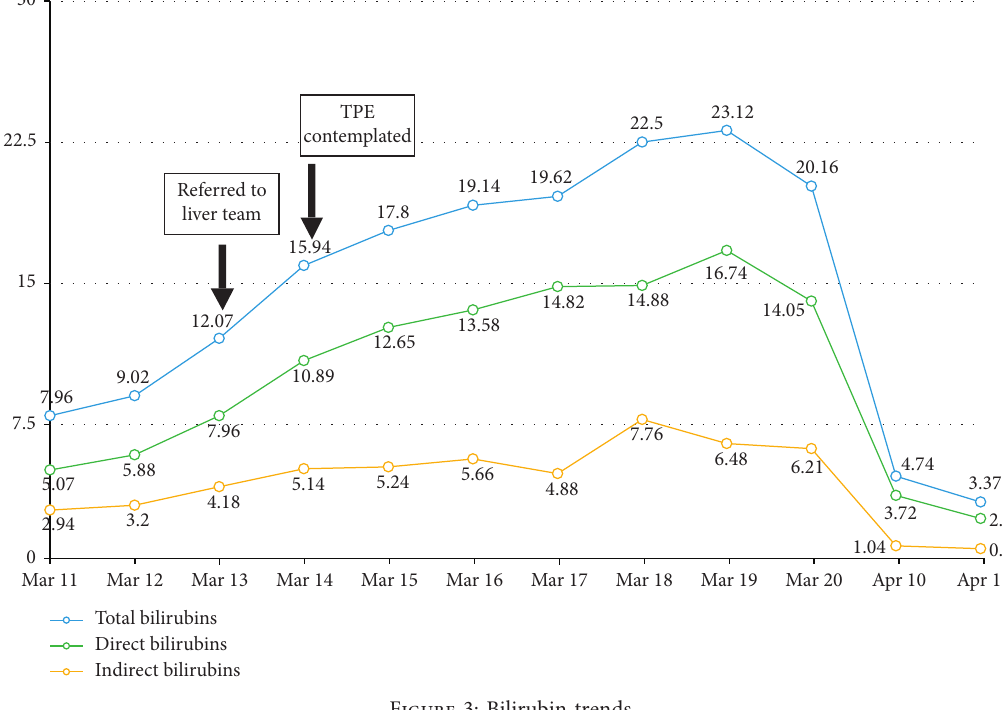
Figure 3: Bilirubin